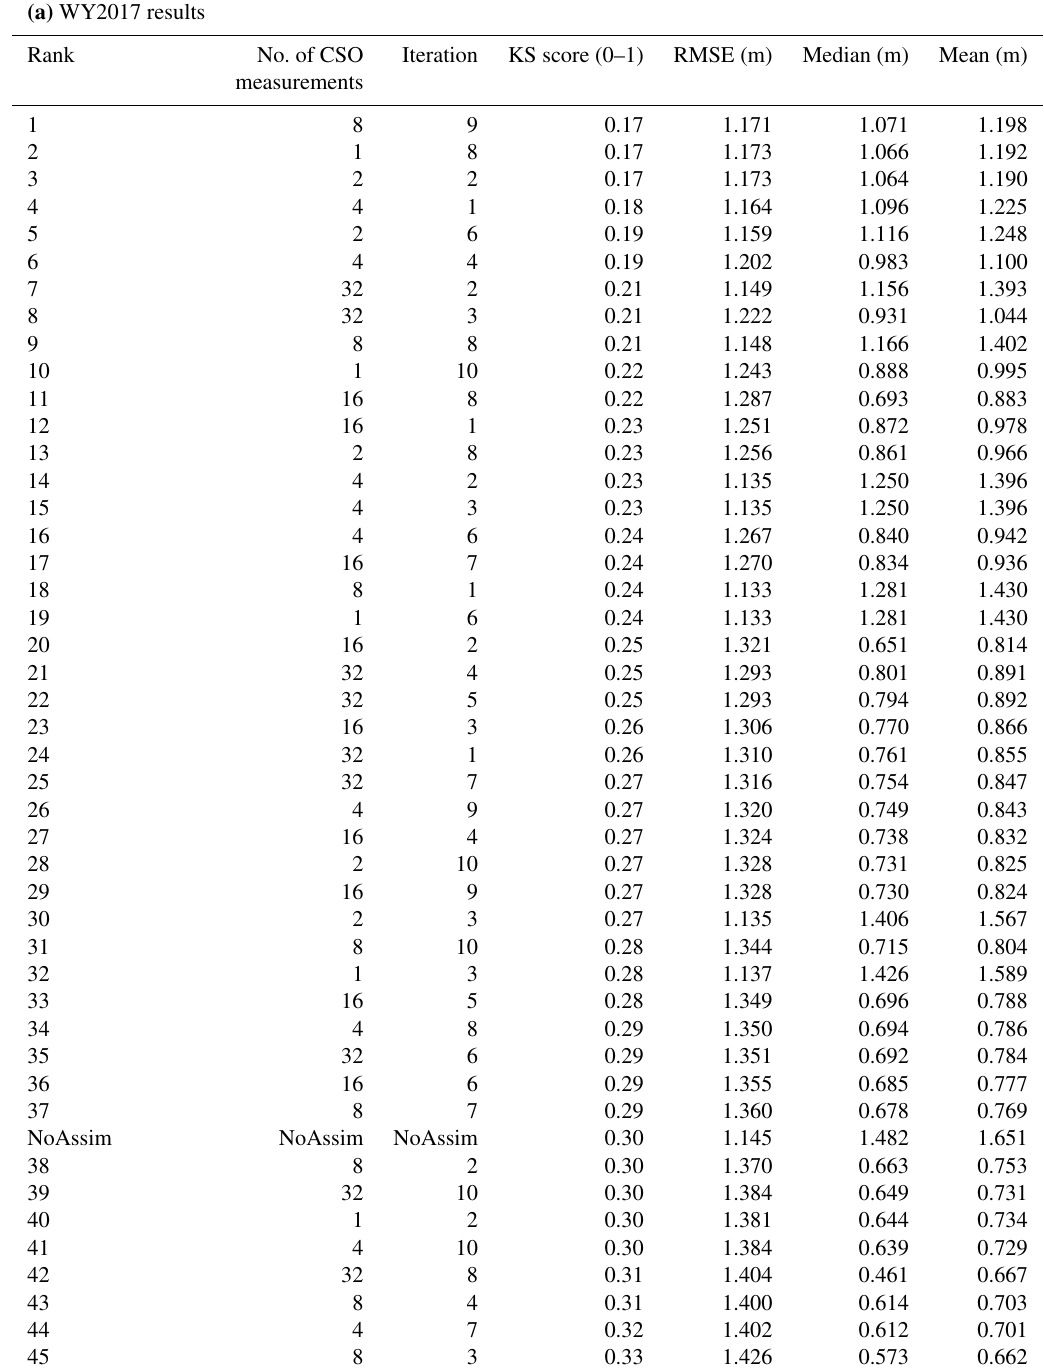
Table F1. Ranked spatial results. Spatial distribution ensemble results ranked by Kolmogorov–Smirnov (KS) score for water year (WY) 2017 (a) and WY2018 (b) . Also included are the root mean squared error (RMSE) and the median